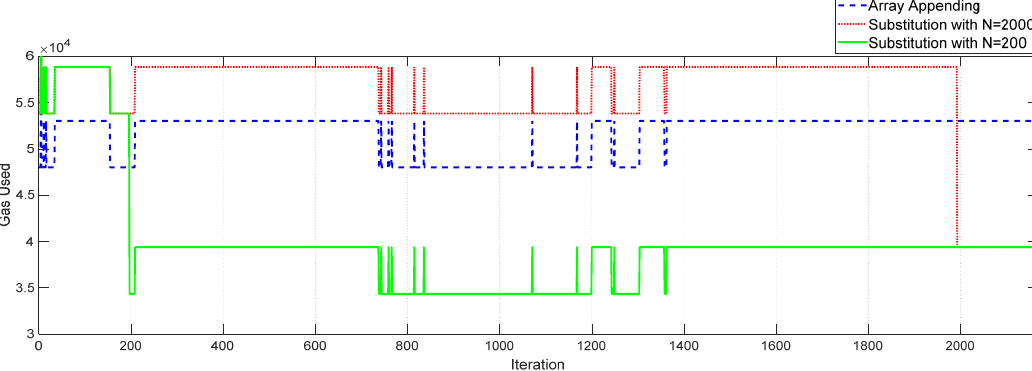
Figure 4. Data captured by the IoT device ( top ); gas consumption of storage options (Gas used: y-axis on left; data points) ( bottom ).